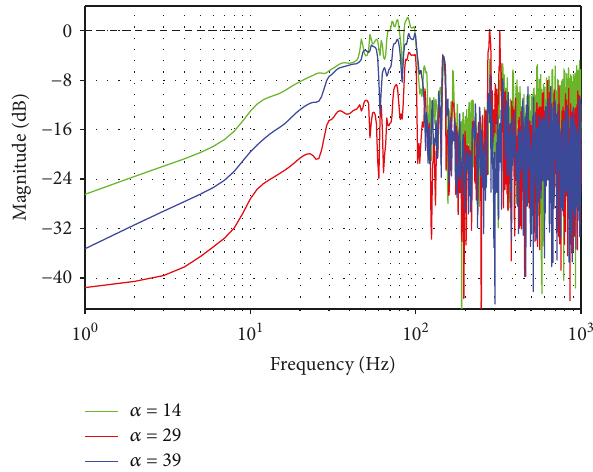
Figure 11: Frequency characteristics of error propagation functions under di ff erent times